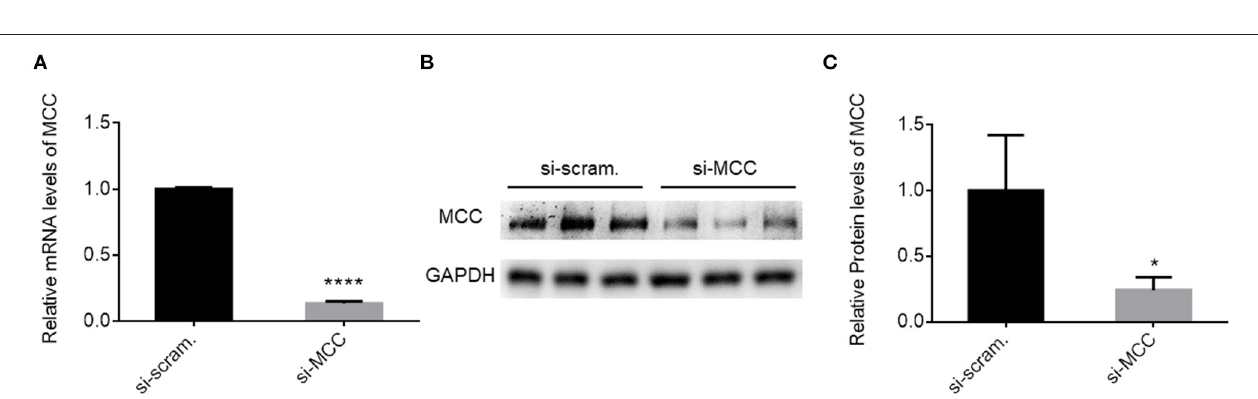
FIGURE 3 | MCC siRNA treatment resulted in marked reduction of MCC expression. (A) qPCR analysis of MCC mRNA in si-scramble control and si-MCC cells which were harvested for mRNA preparation 24h post transfection. (B) Immunoblotting of the MCC protein in the cells in A. (C) Quantification of the MCC protein levels in the blot in B. Each column represents the mean ± SD of the triplicate samples. * p < 0.05, statistically significant. **** p < 0.0001, extremely